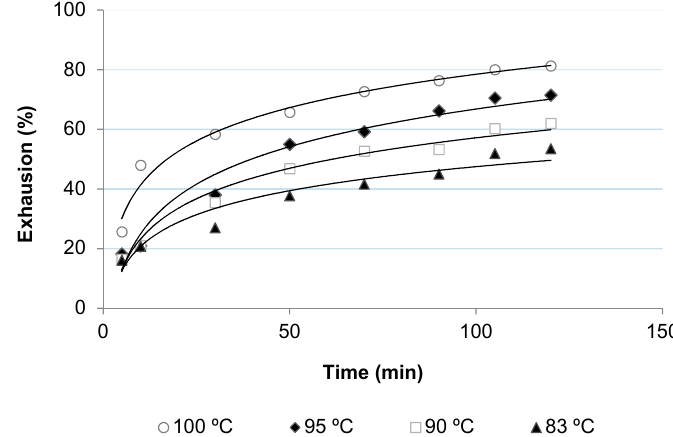
Figure 2. Dyeing kinetics for polyester (polyethylene terephthalate) (PES) fabric dyed with Disperse Red 167 and Coumarin.